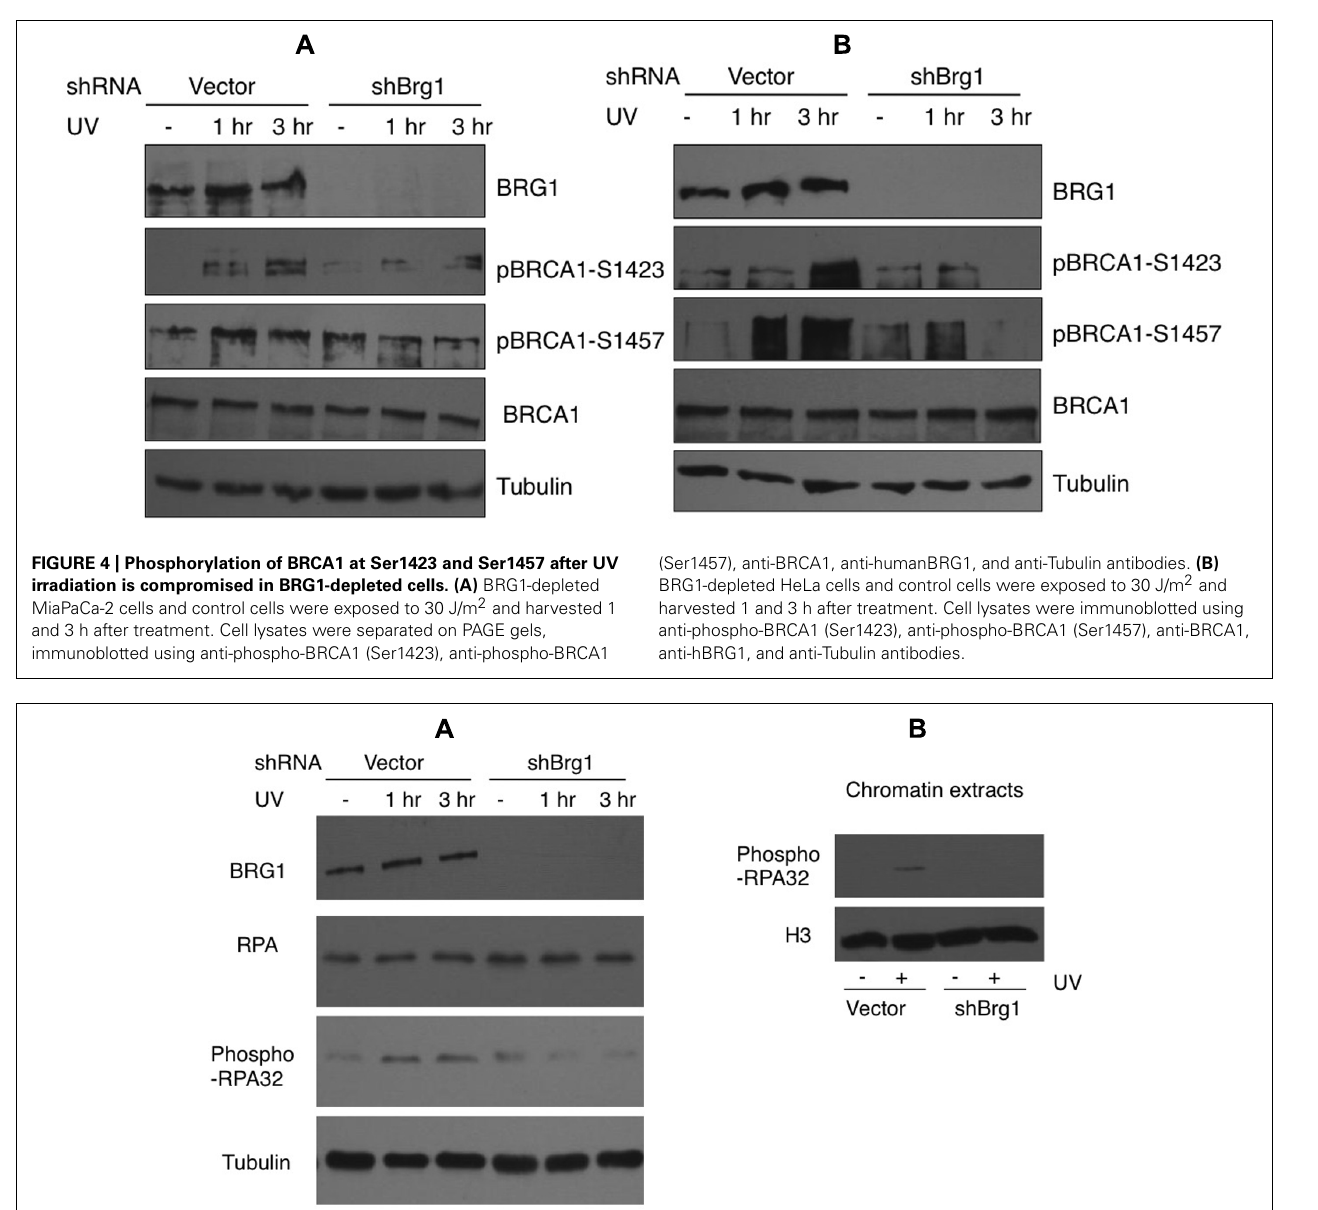
FIGURE 5 | BRG1 depletion affects UV-induced phosphorylation of RPA. (A) BRG1-depleted HeLa cells and control cells were exposed to 30 J/m 2 and harvested 1 and 3 h after treatment. Cell lysates were separated on PAGE gels, followed by immunoblotting using anti-RPA32, anti-phospho-RPA32,